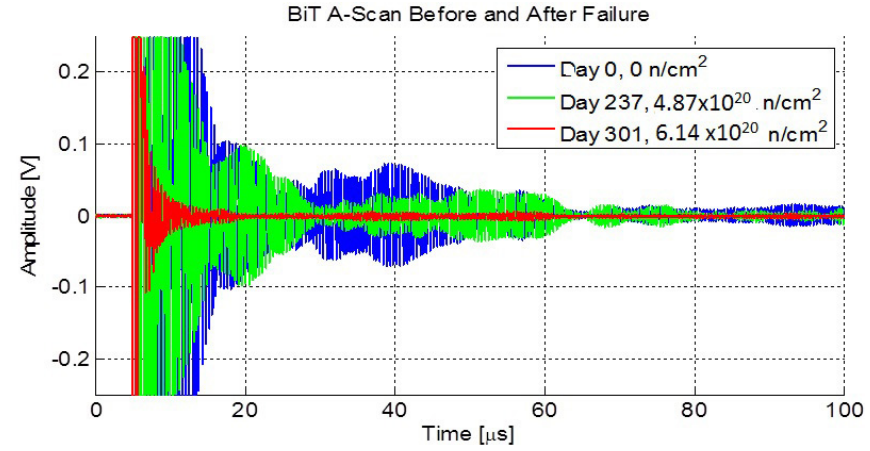
Figure 14. Comparison of A-scans (pulse-echo amplitude versus time) from days 1, 237, and 301 from the BiTi sensor. These represent A-scans from before and after the decline of the sensor [14].